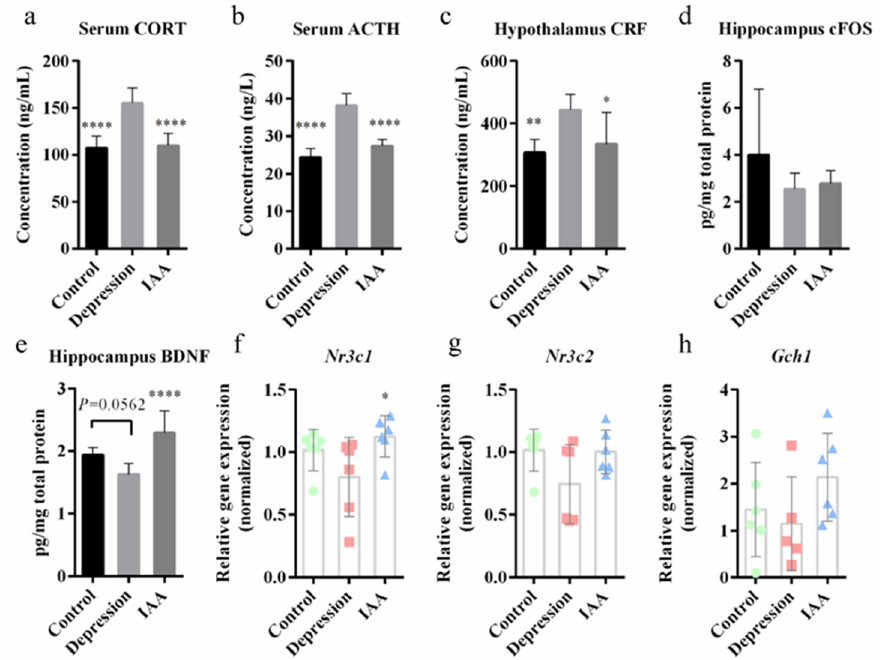
Figure 2. The effects of IAA on the HPA axis and c-Fos/BDNF expression. ( a – c ) Protein levels of CORT and ACTH in the serum and of CRF in the hypothalamus to evaluate the HPA axis response. ( d – e ) Expression of c-Fos and BDNF in the hippocampus. ( f – h ) Shown are the messenger RNA levels of Nr3c1 , Nr3c2 and Gch1 gene in the hippocampus. Data are means and SD, compared with the depression group, * p < 0.05, ** p < 0.01, **** p < 0.0001, one-way ANOVA followed by Tukey’s post hoc test.